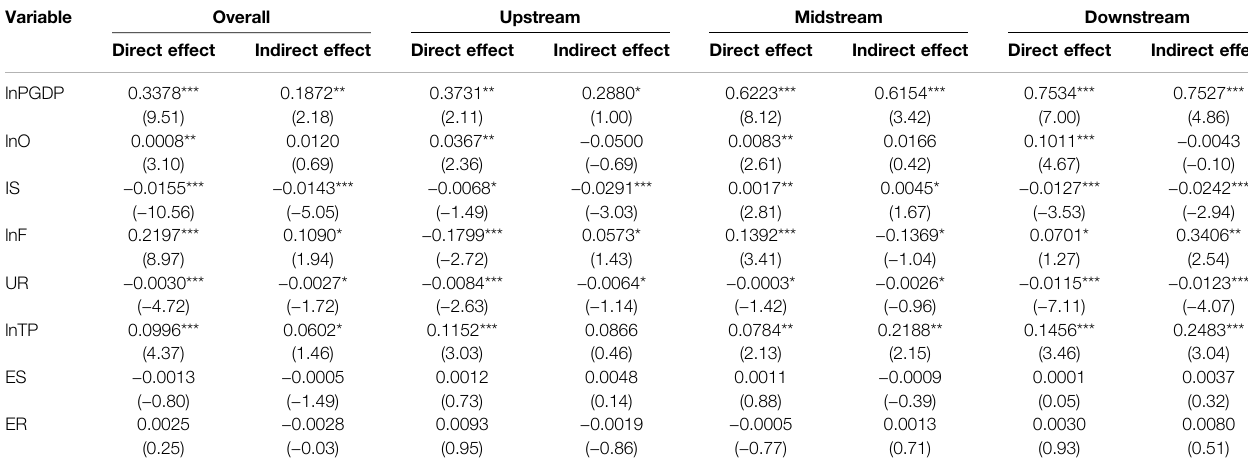
TABLE 7 | Decomposition results of the spatial spillover effect of the spatial Dubin model.